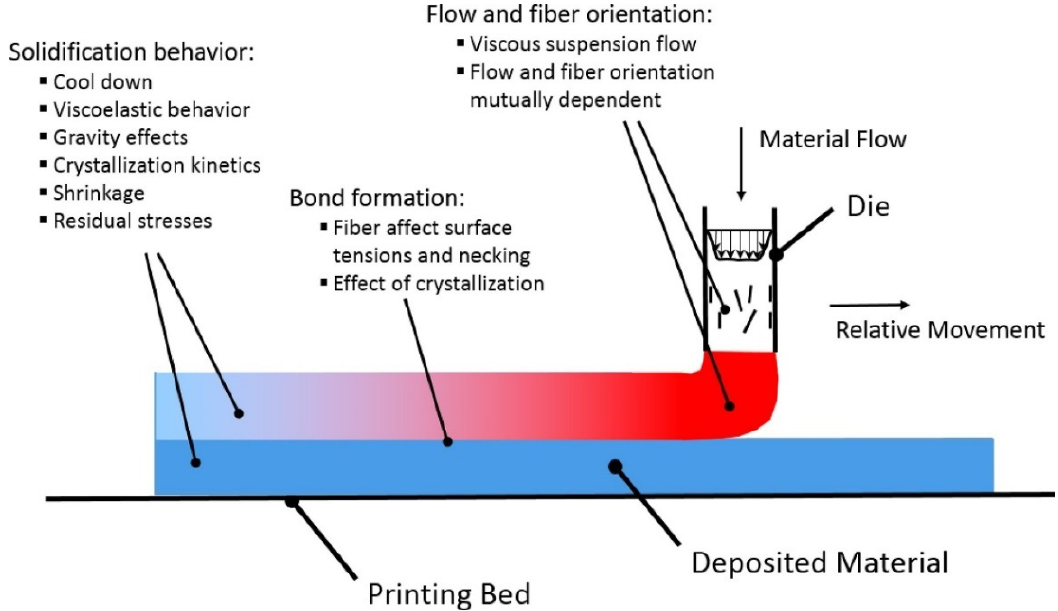
Figure 1. Schematic diagram of the FFF process. Reprinted with permission from reference